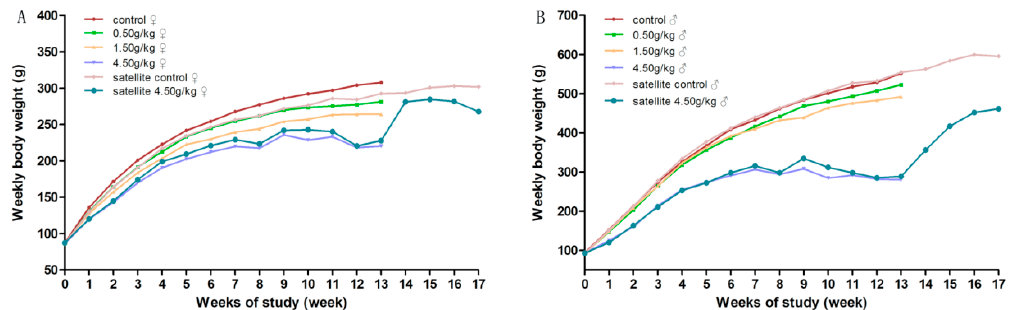
Figure 2. Average body weight of rats orally administrated with gardenia yellow for 90 days. ( A ) female; ( B ) male.